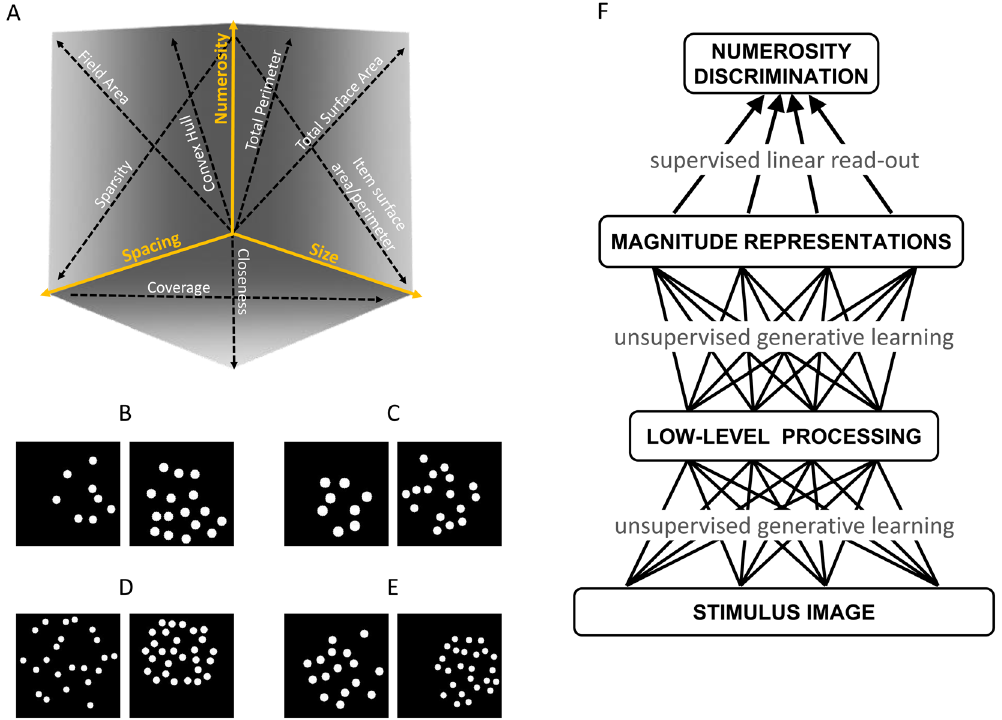
Figure 1. Stimulus space and model architecture. ( A ) The 3D stimulus space defined by the Numerosity, Size and Spacing orthogonal dimensions (adapted from 41 ). Non-numerical features are represented as arrows to indicate the direction in which they increase, and each stimulus image can be represented as a point in this space. Example of stimuli pairs are shown below, where Numerosity can be fully congruent for Size and Spacing ( B ), congruent for Spacing but not for Size ( C ), congruent for Size but not for Spacing ( D ), or fully incongruent for Size and Spacing ( E ). The model architecture is depicted in panel ( F ). At the initial stage, unsupervised deep learning adapts the connection weights of the first two layers (undirected edges) by capturing the statistical distribution of active pixels in the images. During task learning, a supervised linear classifier adapts the connection weights of the final layer (directed edges) in order to minimize discrimination